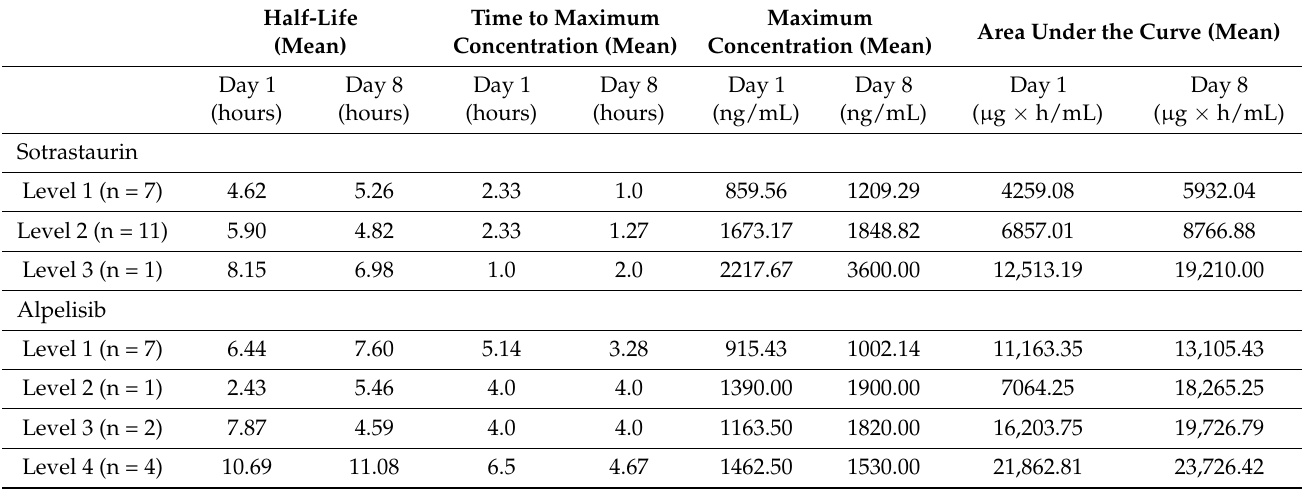
Table A3. Summary of pharmacokinetic parameters.